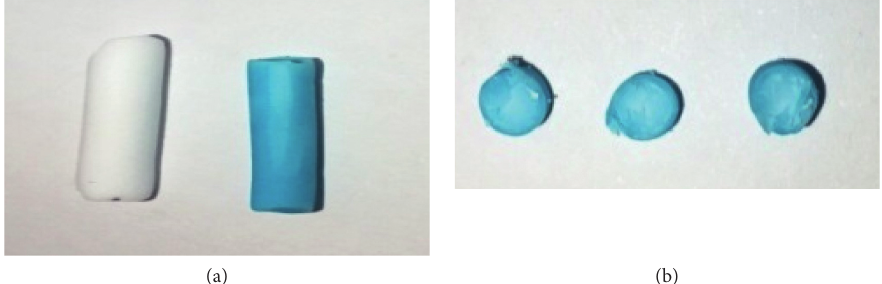
Figure 2: (a) The bare organic monolithic rod (left) and CuBTC-monopol monolith (right) and (b) cross-sectional view of CuBTC-monopol monolith (left, middle, and right).